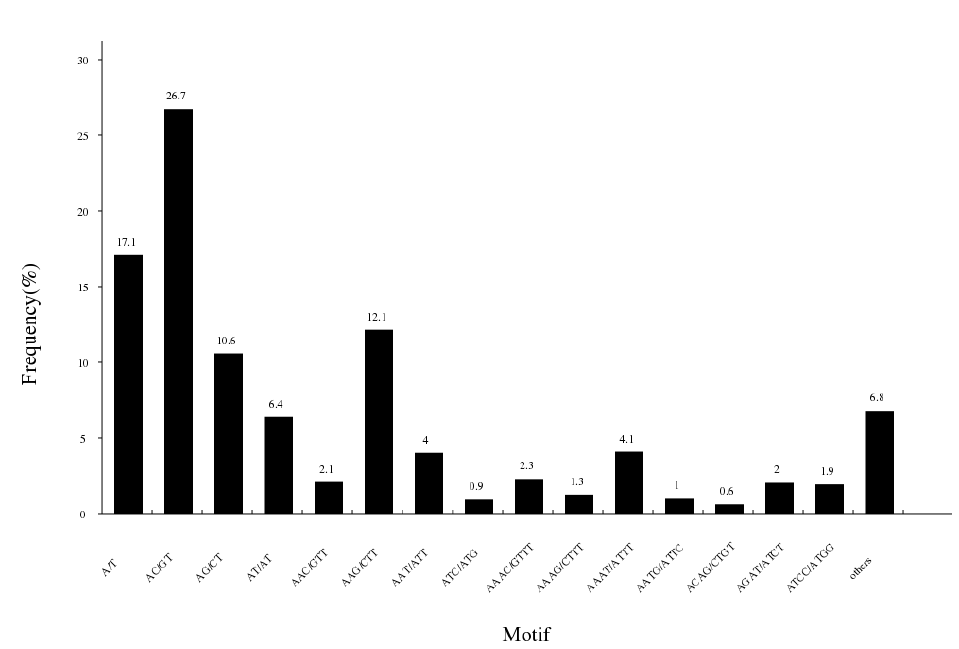
Figure 5. Characterization and frequency of microsatellites with different motif sizes.